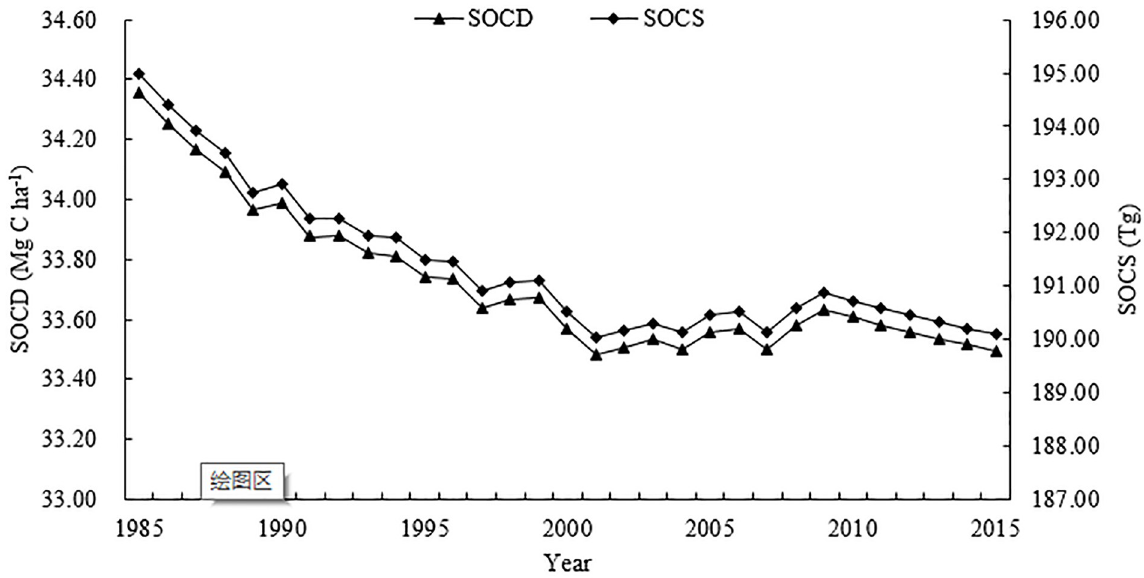
Fig 4. The temporal change of soil organic carbon density (SOCD) and soil organic carbon stock (SOCS) in dry farmland in Jilin Province, China.